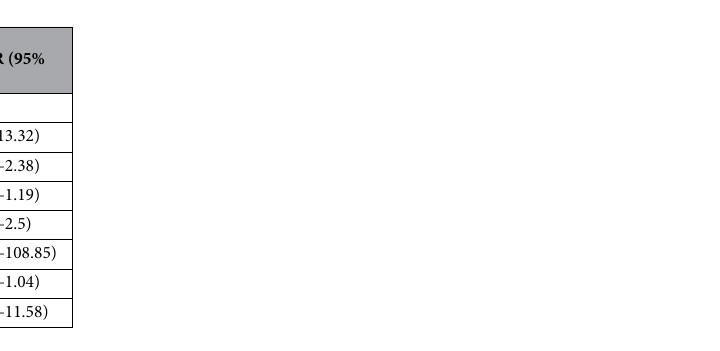
Table 2. Regression model for hierarchical consciousness status. a: Exclude GCS b:μg/day/kg. Crl credible interval, OR odds ratio, RACHS‑1 Risk Adjustment in Congenital Heart Surgery, pSOFA pediatric Sequential Organ Failure